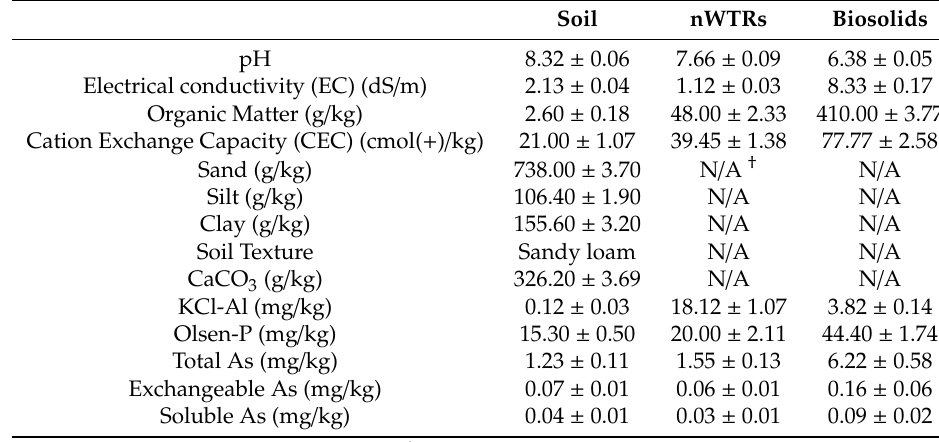
Table 1. General physical and chemical properties of experimental soil, nanoscale drinking water treatment residuals (nWTRs), and